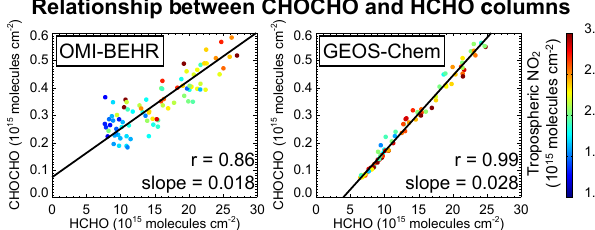
Figure 9. Relationship between CHOCHO and HCHO vertical columns over the eastern US (75–100 ◦ W, 29.5–45 ◦ N) in June– August 2006 and 2007 color coded by tropospheric NO 2 columns. OMI values with CHOCHO AMFs computed from BEHR scatter- ing weights are compared to GEOS-Chem values. Lines and re- ported slopes are from reduced major axis